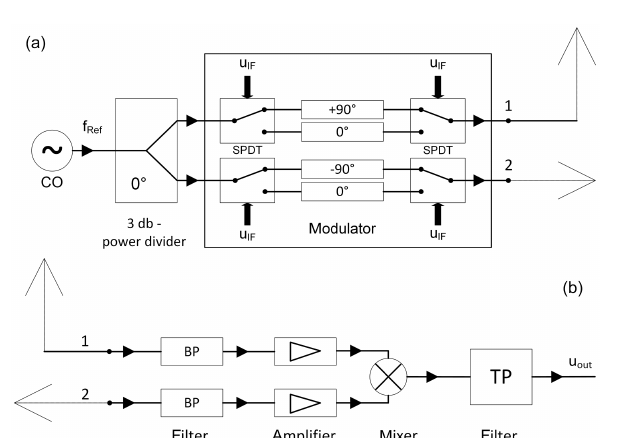
Figure 2. Schematic of dual-mode radio transmitter (a) and re- ceiver (b)